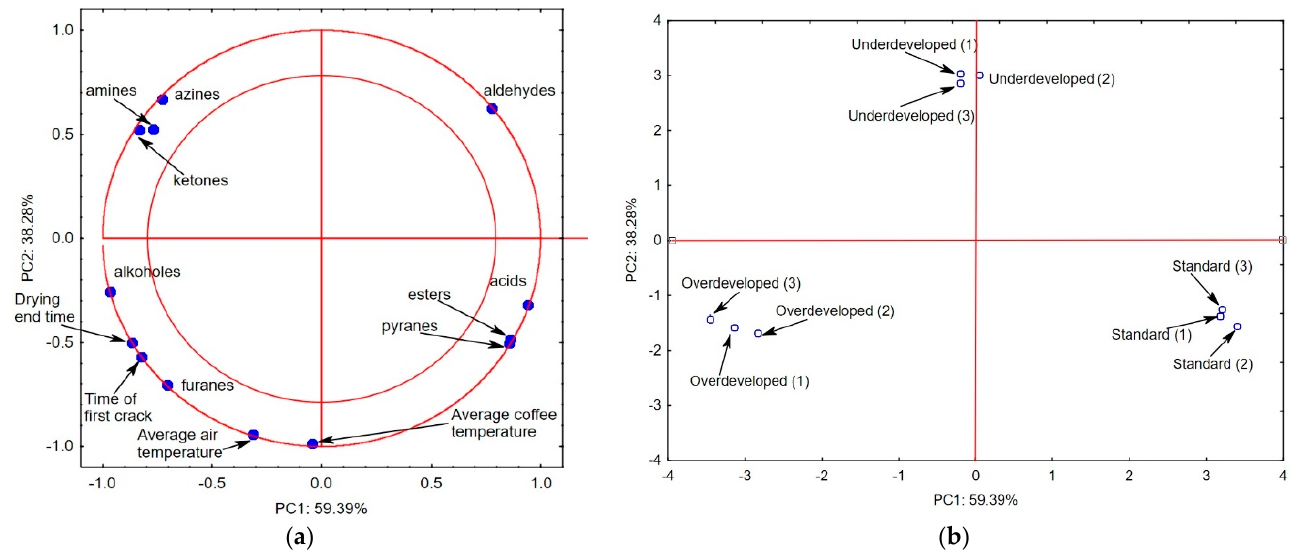
Figure 2. Projection of variables: volatile compounds characterizing the types of roasting, temperature of air, temperature of beans, and time to the first crack on the PC1 and PC2 scores plot—( a ); projection of cases characterizing the type of roasting on the PC1 and PC2 loadings plot—( b ).